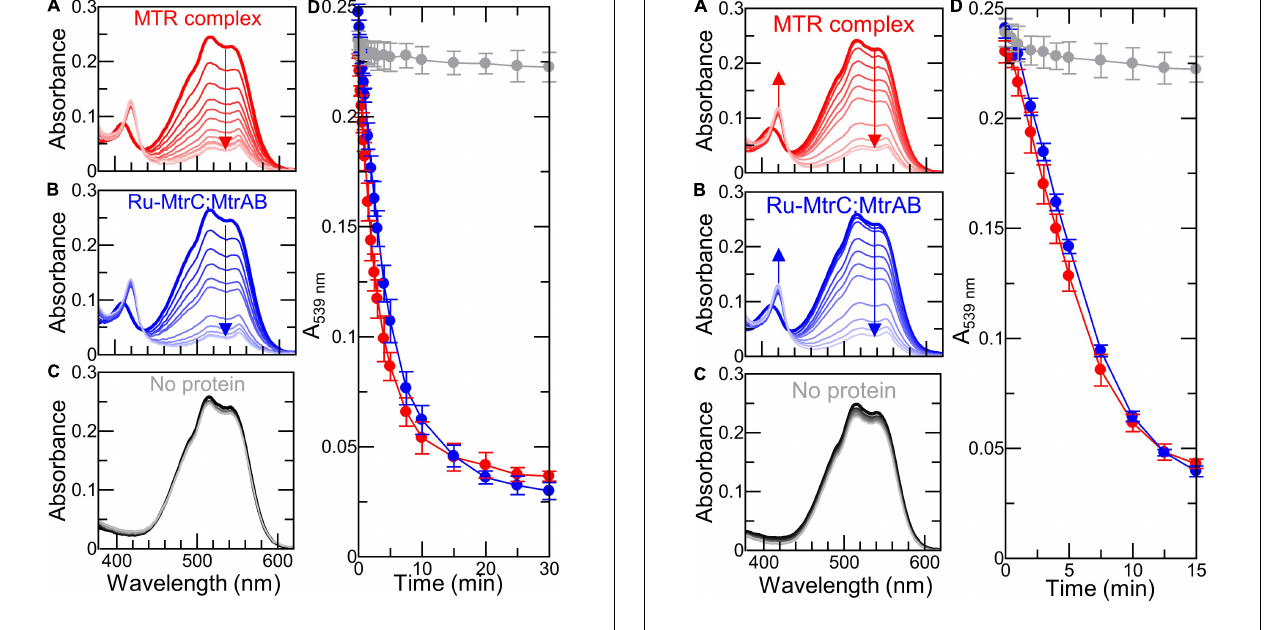
FIGURE 7 | Light-driven electron transfer across (proteo-)liposome bilayers with graphitic N-doped carbon dots. (A–C) Spectra of 6 nM (proteo-) liposomes containing RR120 with indicated proteins before (thick line) and over 15 min irradiation (thin lines) with visible light (2.5 kW m − 2 ); arrows indicate reduction of hemes and bleaching of RR120. Samples in 50 mM Tris:HCl, 10 mM KCl, 25 mM EDTA, AND 10 µ g ml − 1 graphitic N-doped carbon dots, pH 8.5. Scattering contributions from carbon dots and liposomes have been subtracted; see text for details. (D) Time course showing bleaching of encapsulated RR120 in (proteo-) liposomes from (A–C) with data points connected for clarity. Data are the average of n = 3 datasets, and error bars show standard